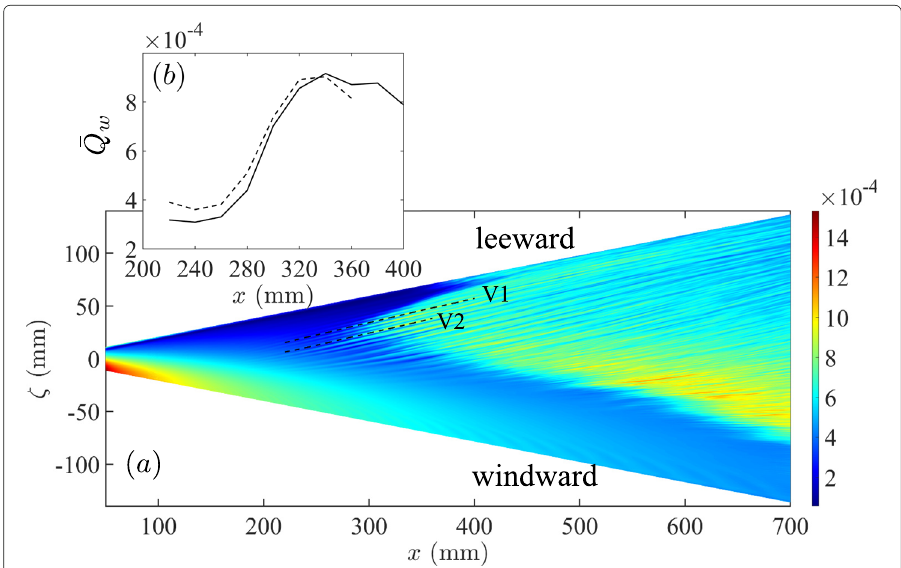
Fig. 4 a The temporal mean of the wall heat flux ¯ Q w . Dashed lines represent two trajectories of stationary crossflow vortices V1 and V2 determined by the local maximum of ¯ Q w . ¯ Q w along the two trajectories are given in b with solid and dashed lines respectively for V1 and